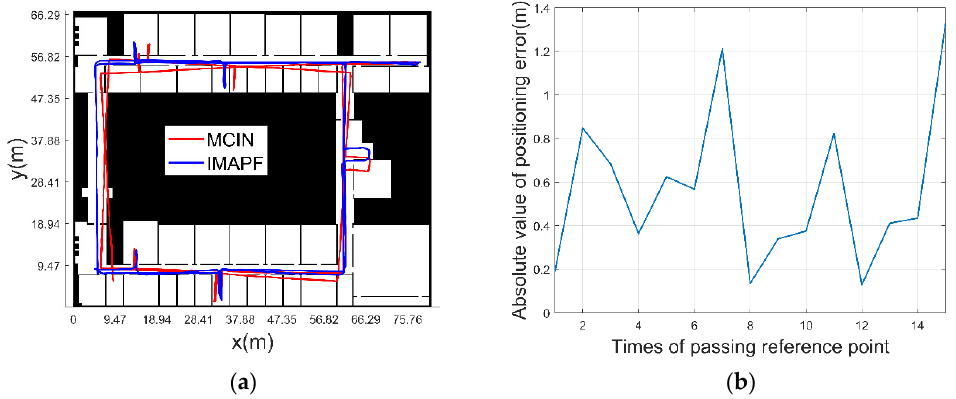
Figure 18. Navigation trace comparison and curve of absolute value of positioning error with unknown initial position and heading. ( a ) Positioning trace comparison diagram. ( b ) Absolute value of the positioning error.